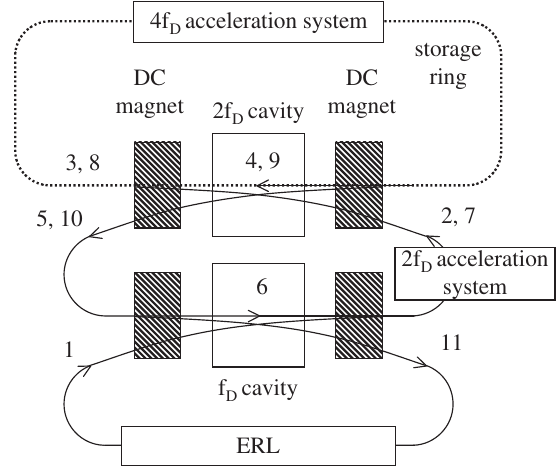
FIG. 8. Four-turn system with the cascading of two two-turn systems with a ring-shaped beam transport. Bunch from ERL is injected to the beam transport (1). Next, bunch is injected to ring (2), circulates twice (3,4), and is extracted from ring to transport (5). Bunch passes through two-turn system in transport without deflection (6) and is injected back into ring (7). Bunch circulates twice through ring (8,9), is extracted to transport (10), and further to ERL (11).